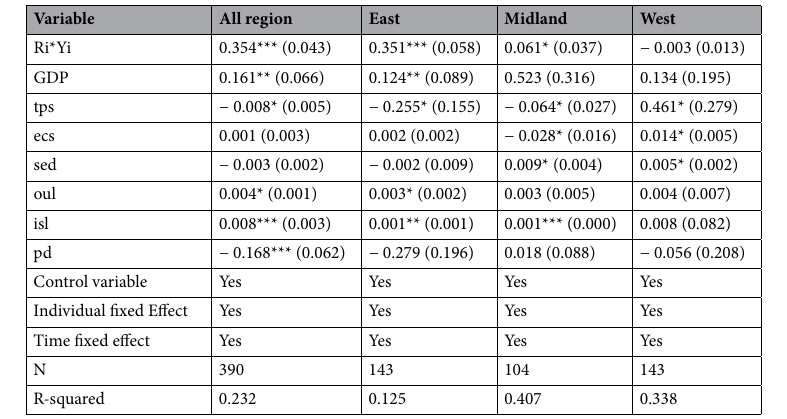
Table 5. Influence of ETS on ecologicalization efficiency of industry. ***, ** and * represent significance levels of 1%, 5% and 10% respectively, standard error is in